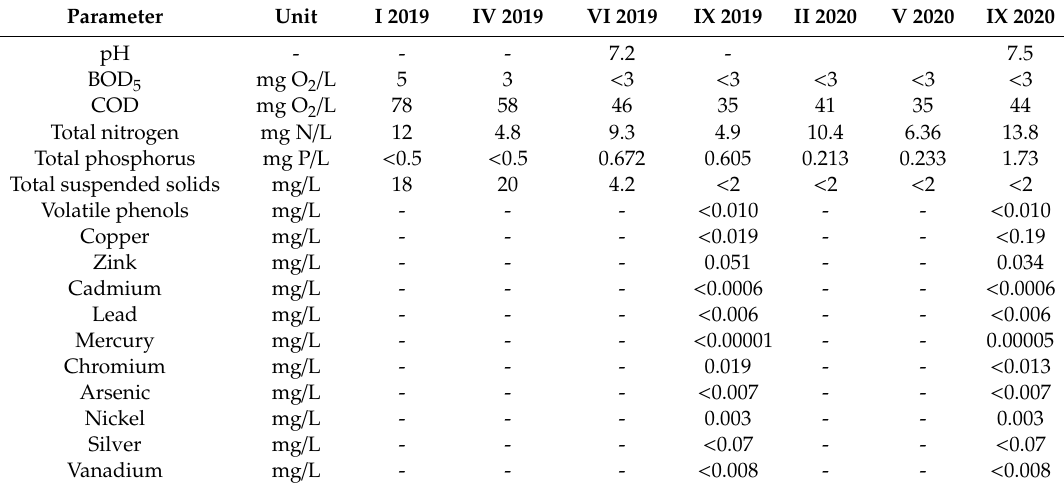
Table 6. Detailed analysis of treated wastewater flowing out of the treatment plant in Wydminy after